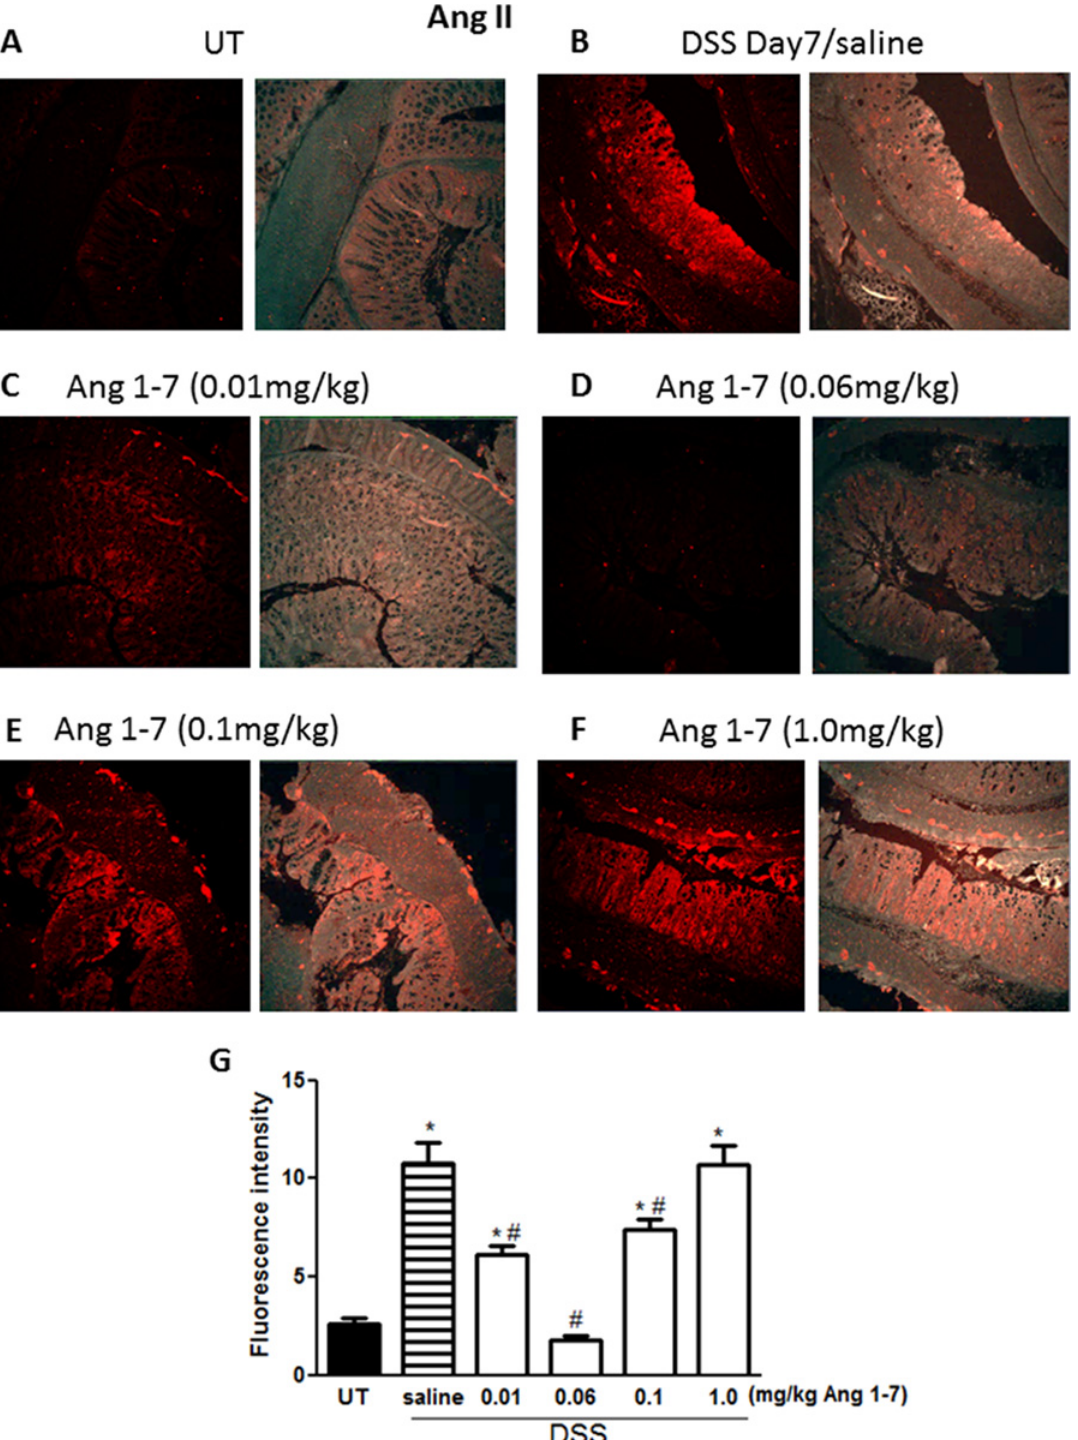
Fig 11. Immunofluorescent detection of Ang II in colon sections. Colon sections taken from untreated (UT) mice or mice treated with DSS for 7 days plus Ang 1 – 7 or saline were immunostained with antisera against Ang II. Immunofluorescent (Alexa Fluor) signals shown in left side of panels A-F are overlaid with DAPI stain on right side to show tissue architecture for the conditions indicated. Panel G represents quantitative assessment of fluorescence intensity (arbitrary units). Histobars represent means ± SEM for 3 mice in each group. Asterisk denotes significant difference from UT mice, with p < 0.05, and # denotes significant difference from DSS/ i.p saline (vehicle) treated mice, with p <